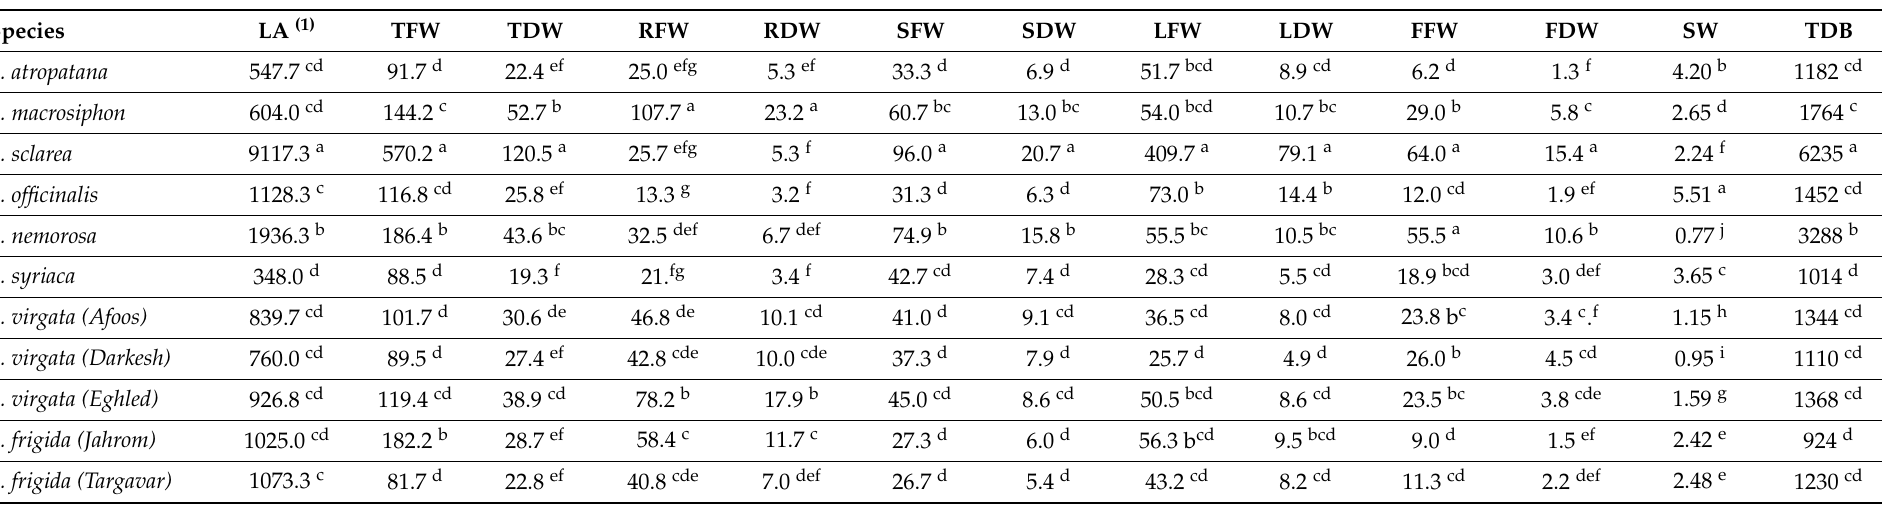
Table 1. Agronomical parameters of various Salvia species after two years of cultivation (1)